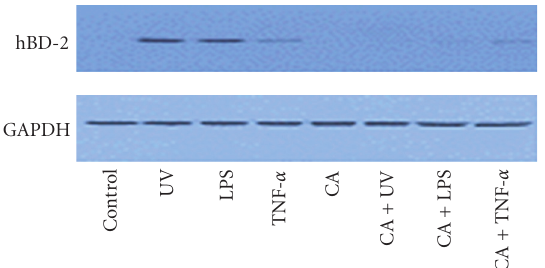
Figure 2: Expression of hBD protein in keratinocytes were evaluated by Western blotting using polyclonal antibody to hBD at 6, 12, and 24 hours post stimulation. The expression of hBD was decreased after additional treatment with calcipotriol compared to stimulation with LPS, TNF- α , and UVB irradiation in the